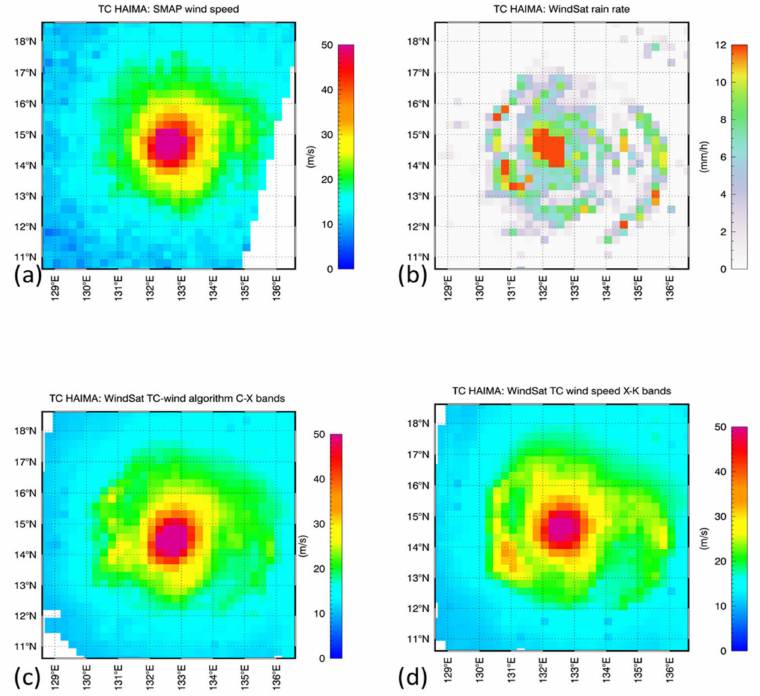
Figure 13. SMAP and WindSat passes over Typhoon Haima on 10/17/2016. Both overpasses occurred within 5 min at around 21:25 UTC. ( a ) SMAP wind speed. ( b ) WindSat rain rate. ( c ) WindSat TC-wind speed using the C-X-band algorithm. ( d ) WindSat TC-wind speed using the X-K-band